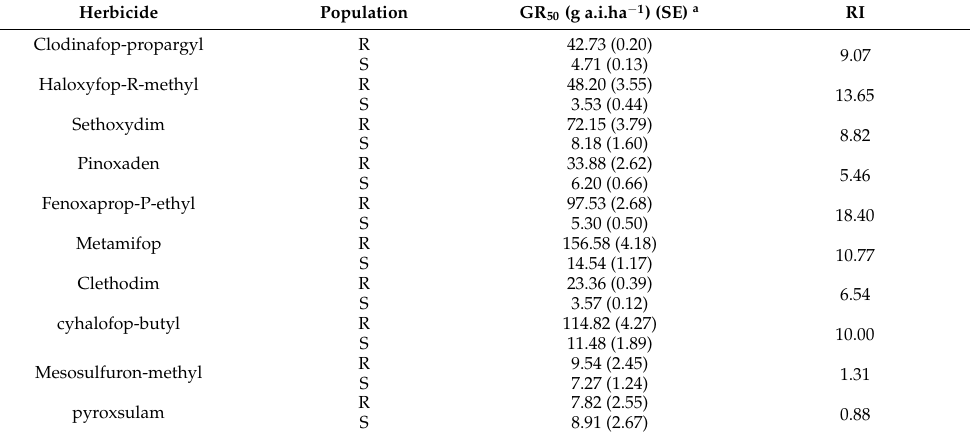
Table 2. Sensitivities of the quizalofop-p-ethyl-resistant and -susceptible Polypogon fugax populations to other acetyl-CoA carboxylase inhibitors and acetolactate synthase